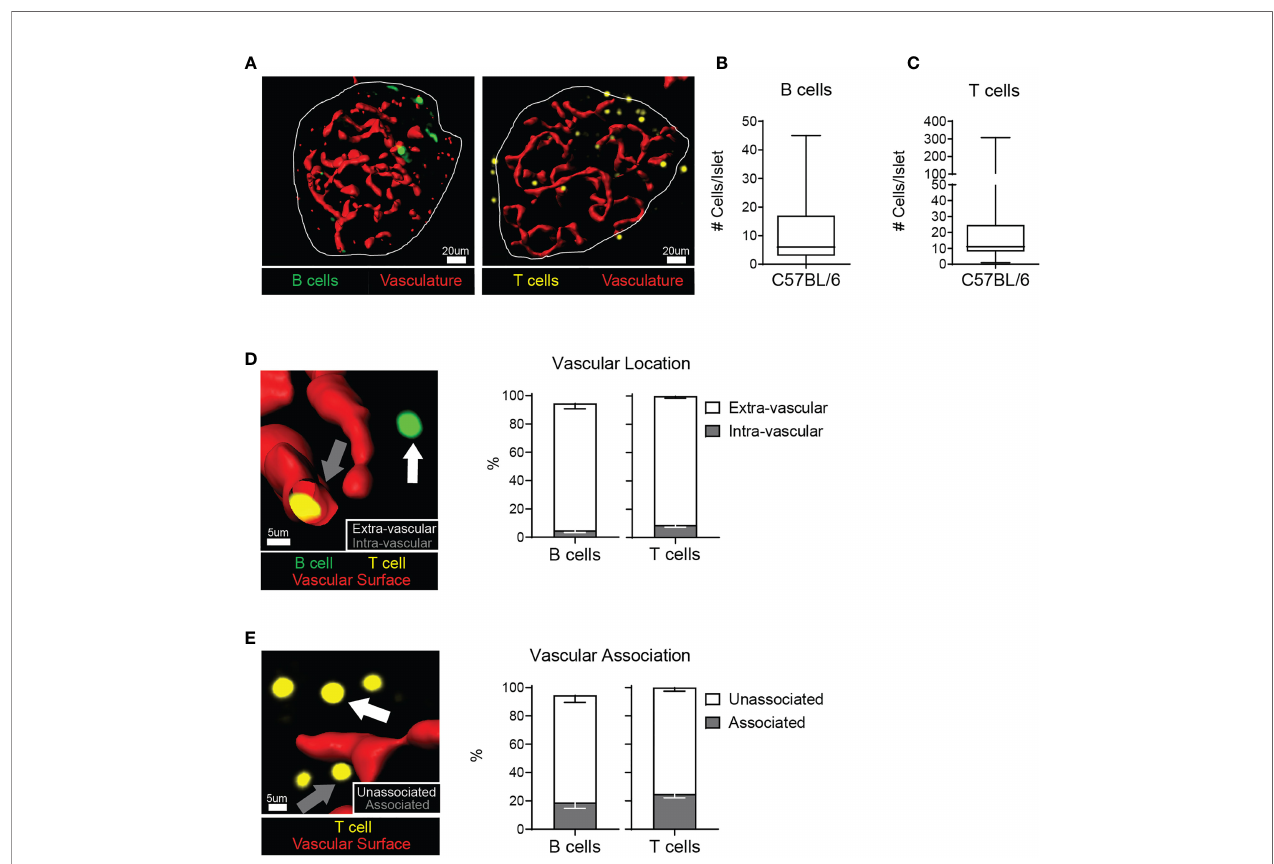
FIGURE 1 | C57BL/6 islets contain T cells and B cells in the parenchyma. Whole explanted C57BL/6 islets were stained for the vasculature (anti-CD31; red), T cells (anti-CD3; yellow), and B cells (anti-B220; green) and imaged by 2-photon microscopy. (A) Representative images. Vasculature is represented by a 3D surface rendering. (B) Number of B220+ cells per islet. (C) Number of CD3+ cells per islet. (D) Example image and quanti fi cation of the intra- or extra-vascular location of T cells and B cells. White arrow: extra-vascular cell. Grey arrow: intra-vascular cell. (E) Example image and quanti fi cation of the vascular association of extra-vascular T cells and B cells. White arrow: Unassociated cell - greater than 1 m m away from the vasculature surface. Grey arrow: Associated cell – within 1 m m of the vascular surface. (A – E) n=37 islets from 3 independent experiments for B cells. n=72 islets from 5 independent experiments for T cells. Error bars: